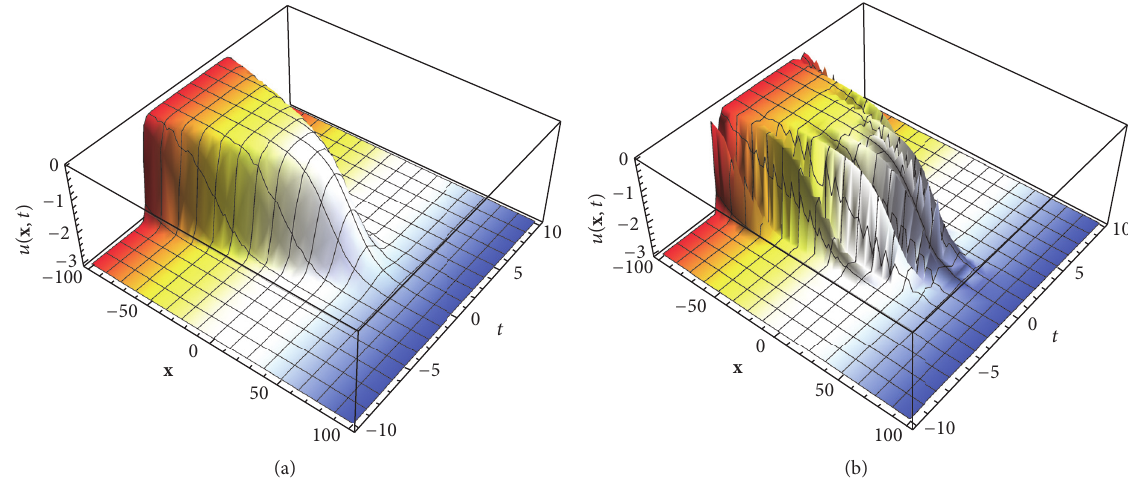
Figure 2: Profiles of the exact solution (37): (a) soliton solution with 𝐵(𝑡) = 0 and (b) solitons solution with 𝐵(𝑡) = 2 sin (5𝑡) .